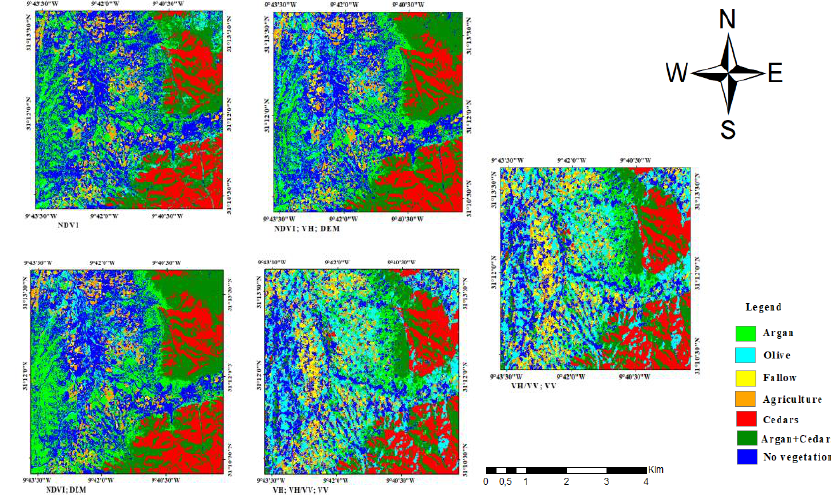
Figure 4 . Resulting maps of the best classifications